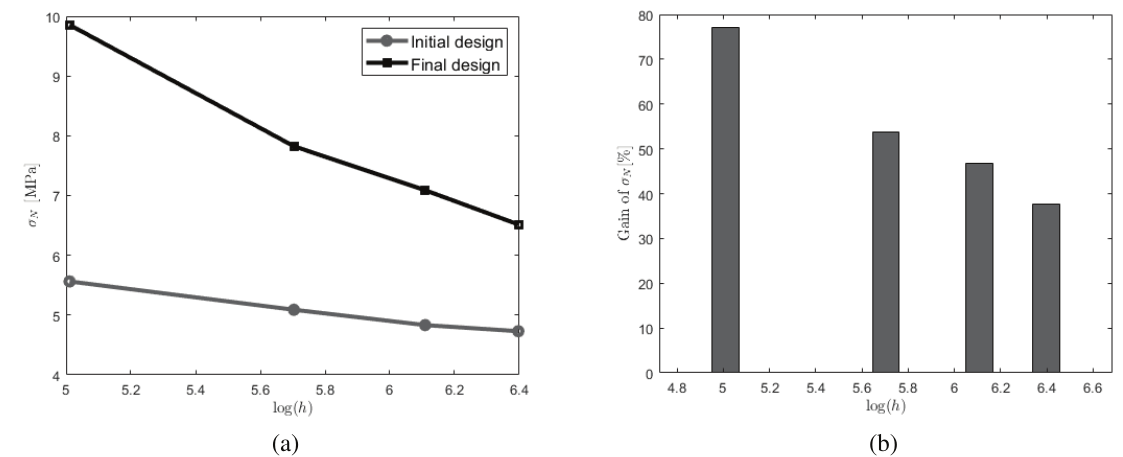
Figure 7. Size effects associated with the strength of the structure ( a ) nominal stress to failure with respect to the height H for initial and optimized topologies; ( b ) gain between initial and optimized designs with respect to the size. For each size, the same topology is